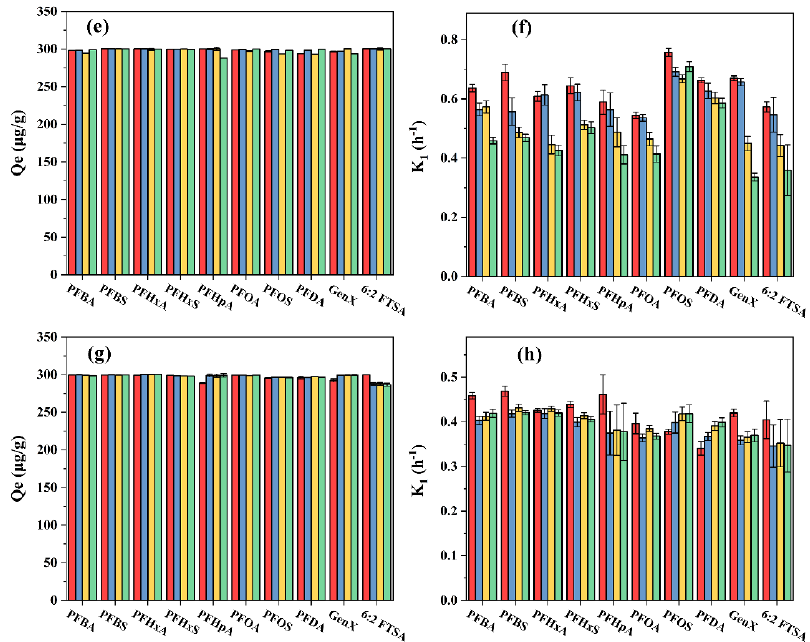
Figure 5. Adsorptive removal of PFASs by various resins in the presence of inorganic anions: ( a , b ) HPR4700; ( c , d ) WA10; ( e , f ) S6368; ( g , h ) A111S.